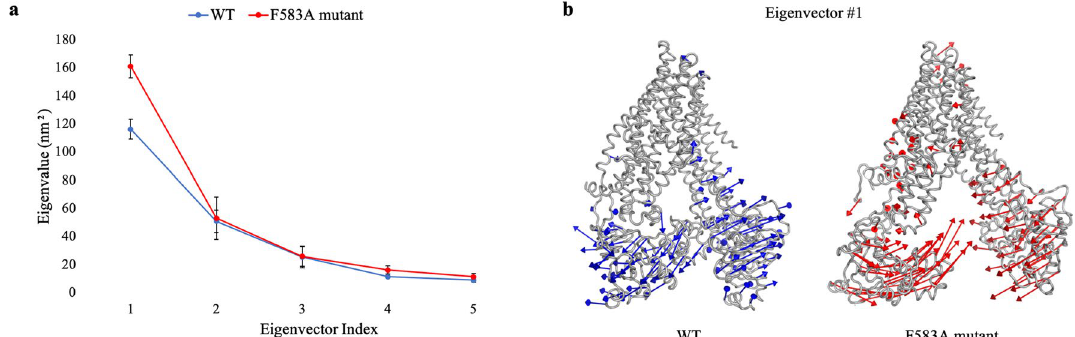
Figure 4. Principal Component Analysis (PCA) of WT (blue) and F583A mutant (red) MRP1. (a) The eigenvalues plotted against the first five corresponding eigenvector indices were obtained from the Cα covariance matrix constructed from the MD trajectory. Eigenvalues are sorted on descending order, the first eigenvector presents the largest variance in relation to the other eigenvectors. (b) Visualization projection of the obtained results is represented by arrows to show the principal components of the protein’s motion throughout the simulations. The lengths of the arrows are proportional to the size of the